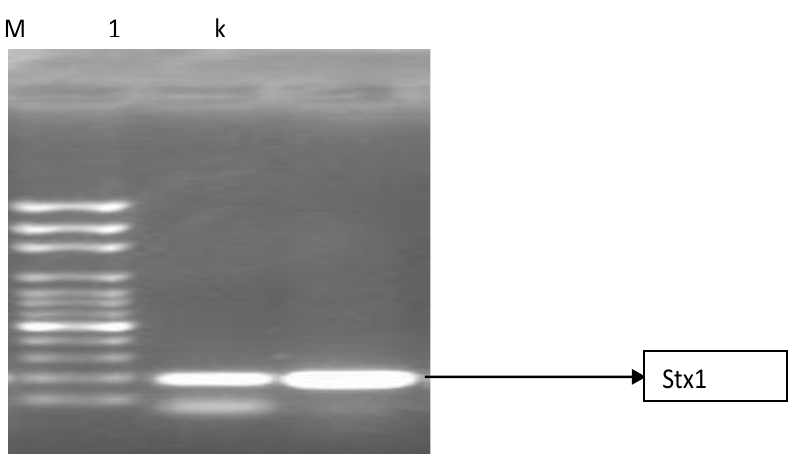
Plate 4. Electrophoretic gel plate of amplified gene for type shiga toxin virulence factors in two of the E. coli isolates.